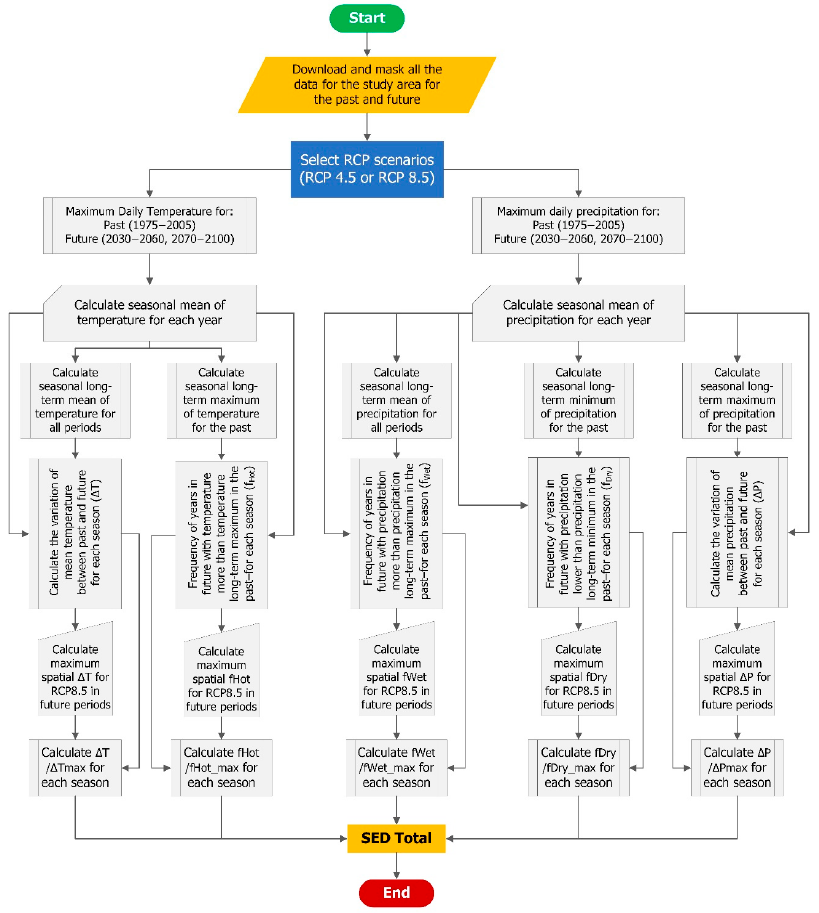
Figure 2. Hotspot identification flowchart.